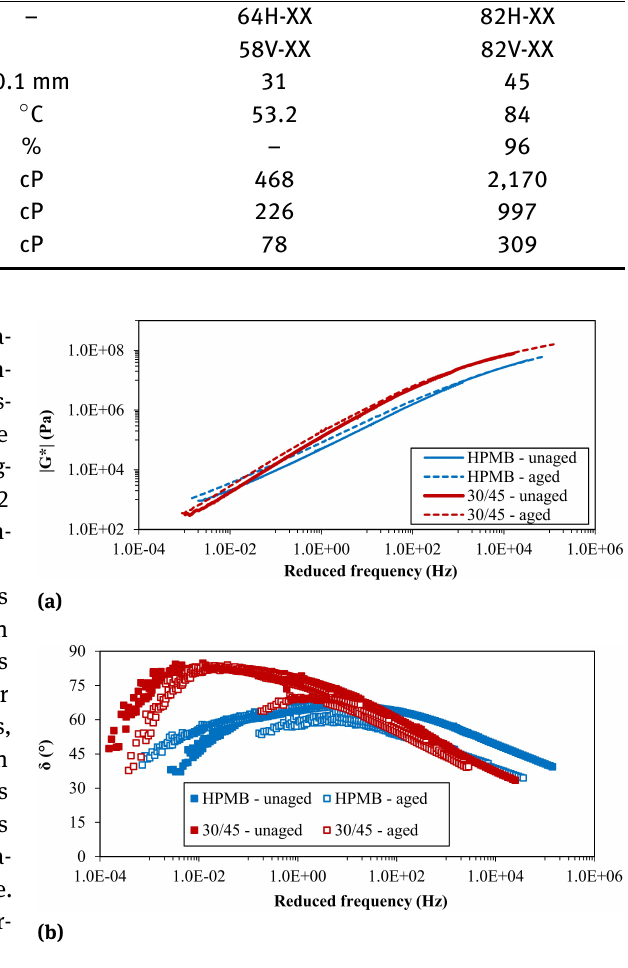
Figure 1: Master curves of AC 30/45 and HPMB before and